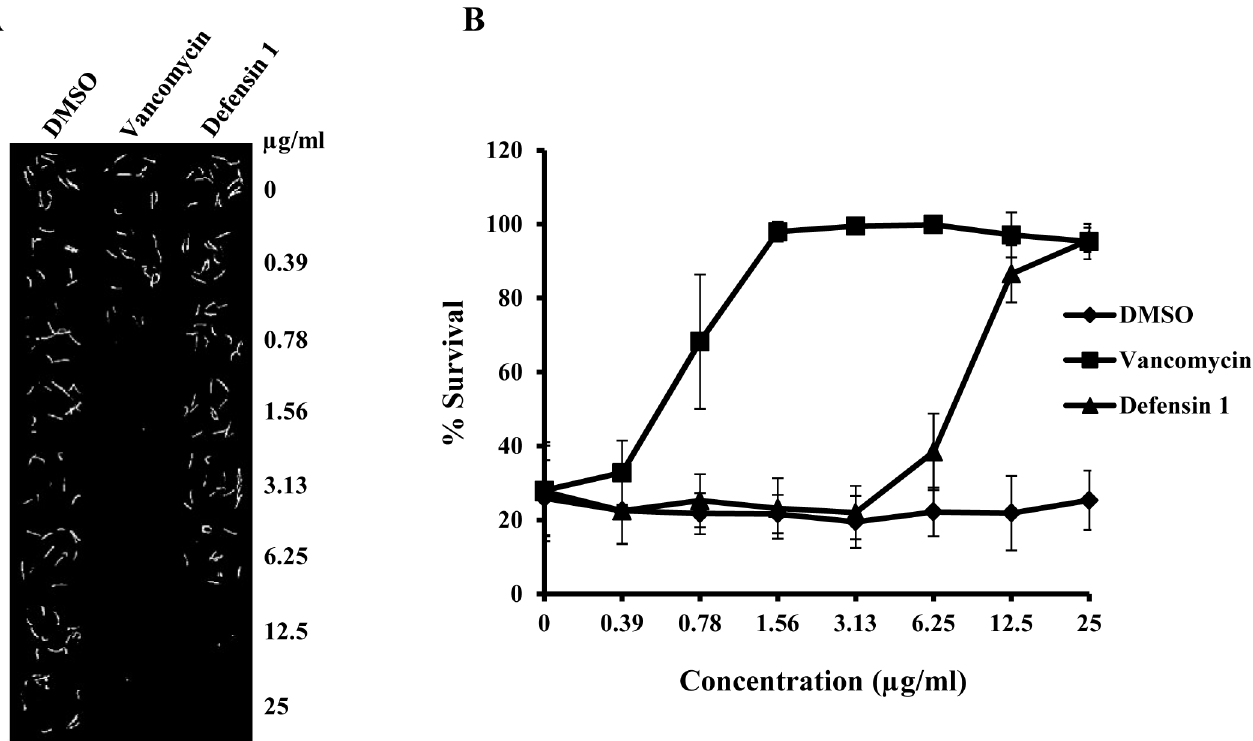
Fig 4. Defensin 1 prolongs survival of C . elegans infected with MRSA. A 384 well assay plate was co-inoculated with nematodes, bacteria and either DMSO (negative control), vancomycin (positive control) or defensin 1. Serial dilutions of the drugs were tested to adjust the concentration between 0.39 – 25 μ g/ml. (A) Sytox Orange stained and bright field images of assay wells containing a gradient of the tested drugs. Dead worms take up the vital dye Sytox Orange and fluoresce. (B) Percent survival of infected worms was calculated from intensity of fluorescence measured in each well of the assay